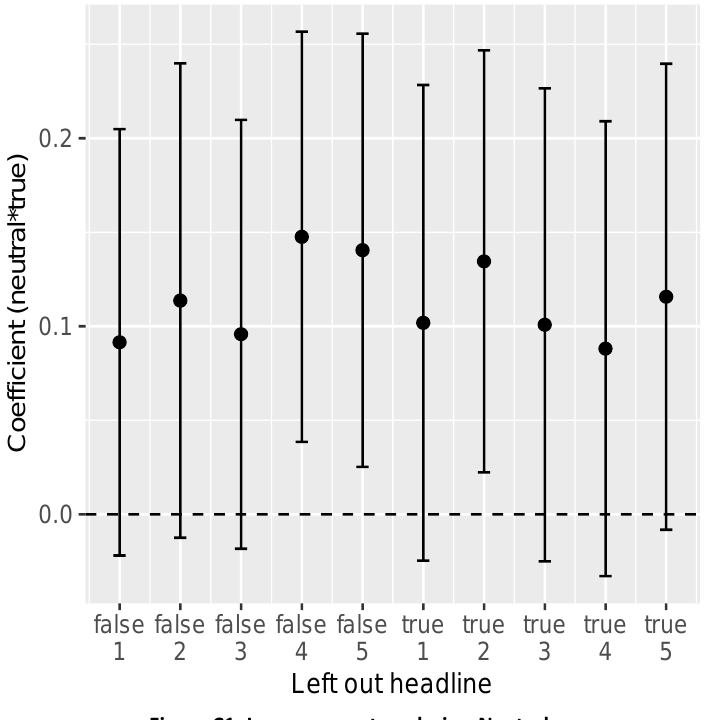
Figure C1. Leave one out analysis – Neutral.